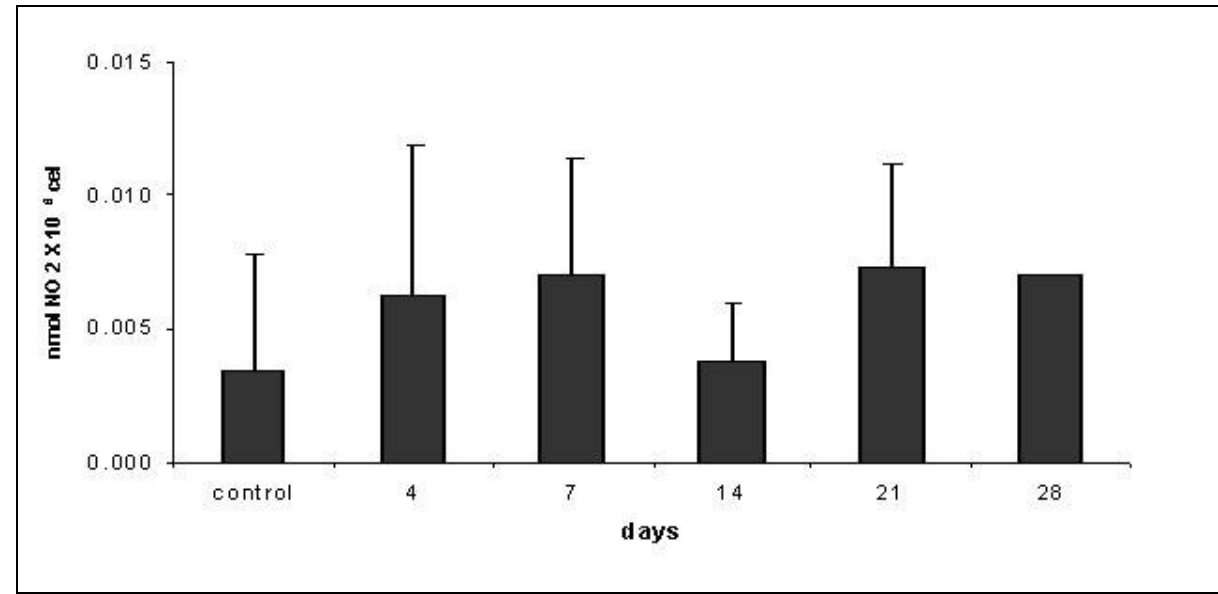
Figure 4. Mean NO concentrations (±SD) in the brochoalveolar lavage fluid of hamsters inoculated with L. interrogans Icterohaemorrhagiae and